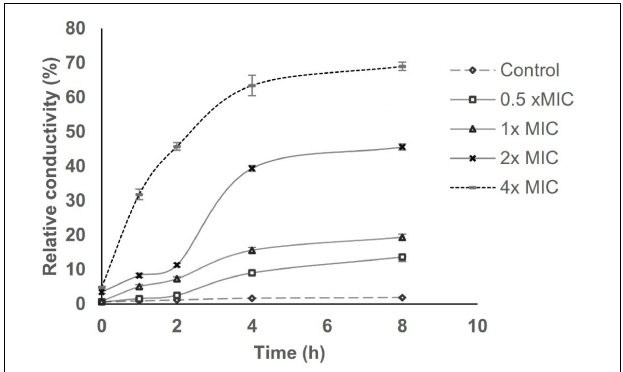
FIGURE 5 | Effect of AWME3 concentrations on the cell membrane perme ability of K. pneumoniae ATCC BAA-2473 strain. Planktonic bacteria sus pension at 10 8 CFU/mL was subjected to various concentrations of AW ME3 ranged from 0.5 (125 µ g/mL) to 4x MIC (1,000 µ g/mL), and incubated for 8 h at 37 ◦ C. REC was calculated at 0, 1, 2, 4, and 8 h based on the values of electrical conductivity. Bacteria without AWME3 treatment was considered as negative control. All values presented as the mean of three independent experiments ±